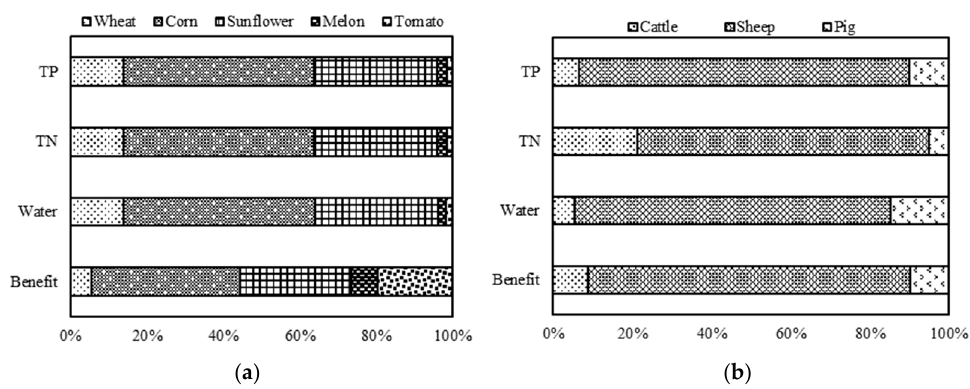
Figure 6. Contribution ratios of different indicators under S1 scenario. ( a ) Agriculture; ( b ) Livestock husbandry.